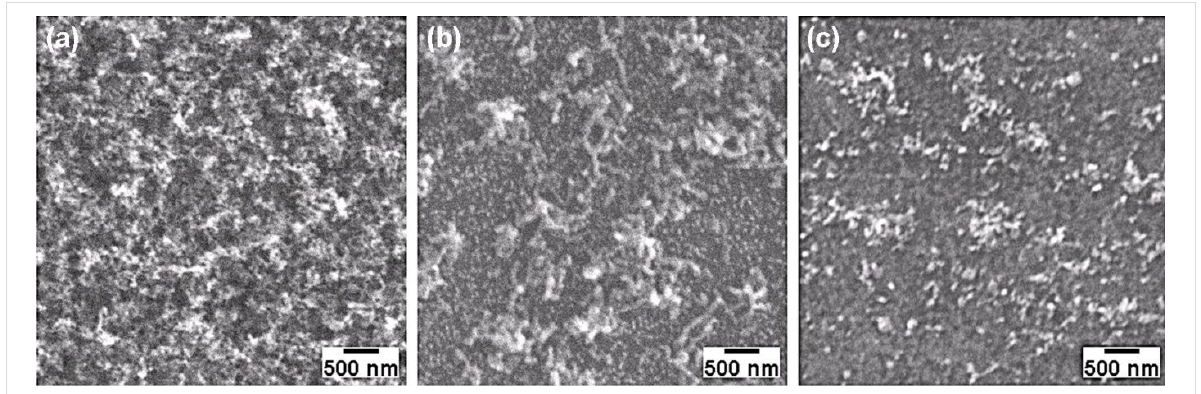
Figure 1: SEM images of MWCNTs grown on ITO-coated glass by CVD at: (a) 550 °C, (b) 525 °C, (c) 500 °C.